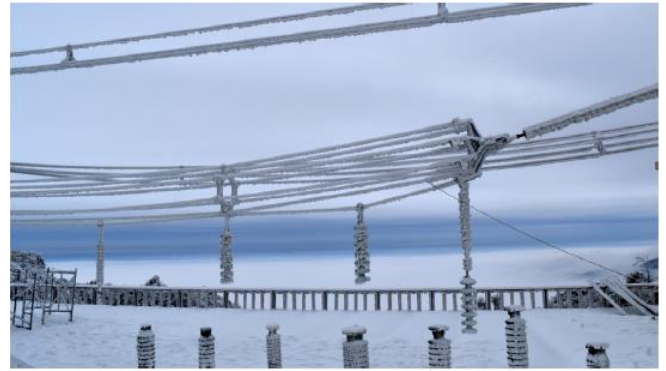
Figure 9. Iced test for transmission lines and insulators [6].